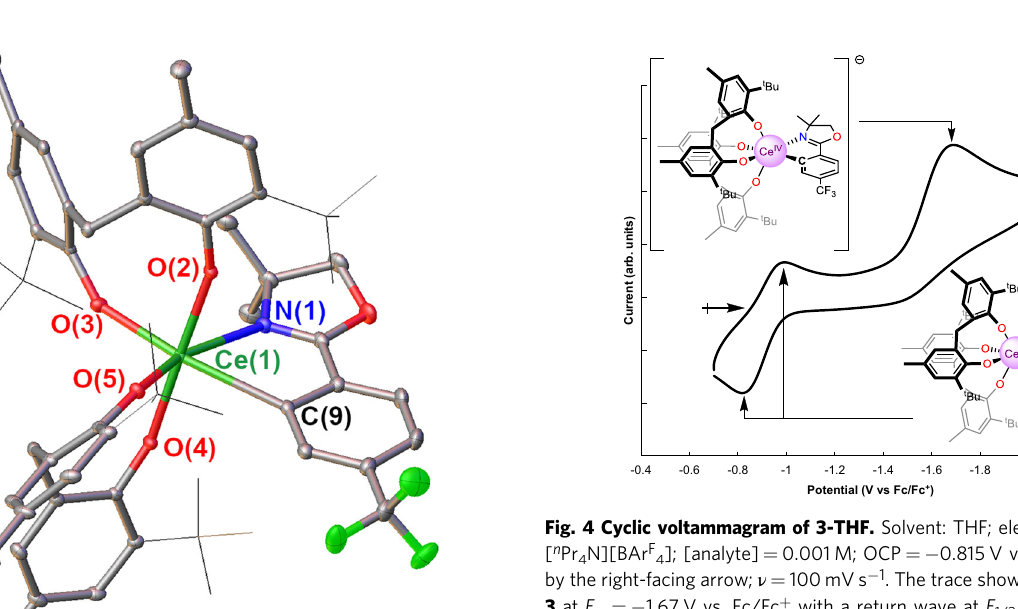
Fig. 2 Syntheses of title Ce IV − C aryl compounds 3-THF and 3-DME. The complex 1 was treated with the isolable aryl lithium 2 to generate the title complexes 3-THF or 3-DME .